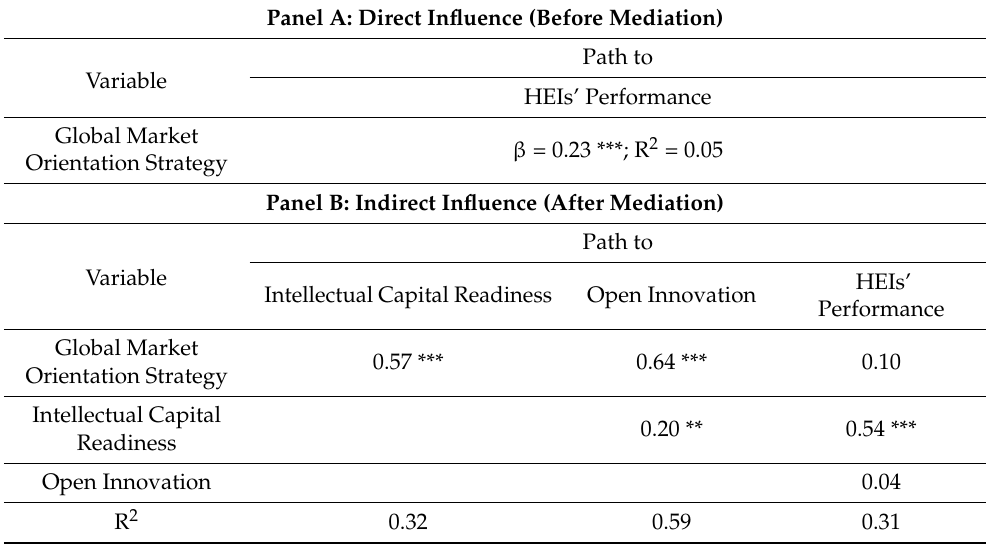
Table 6. Results of structural model